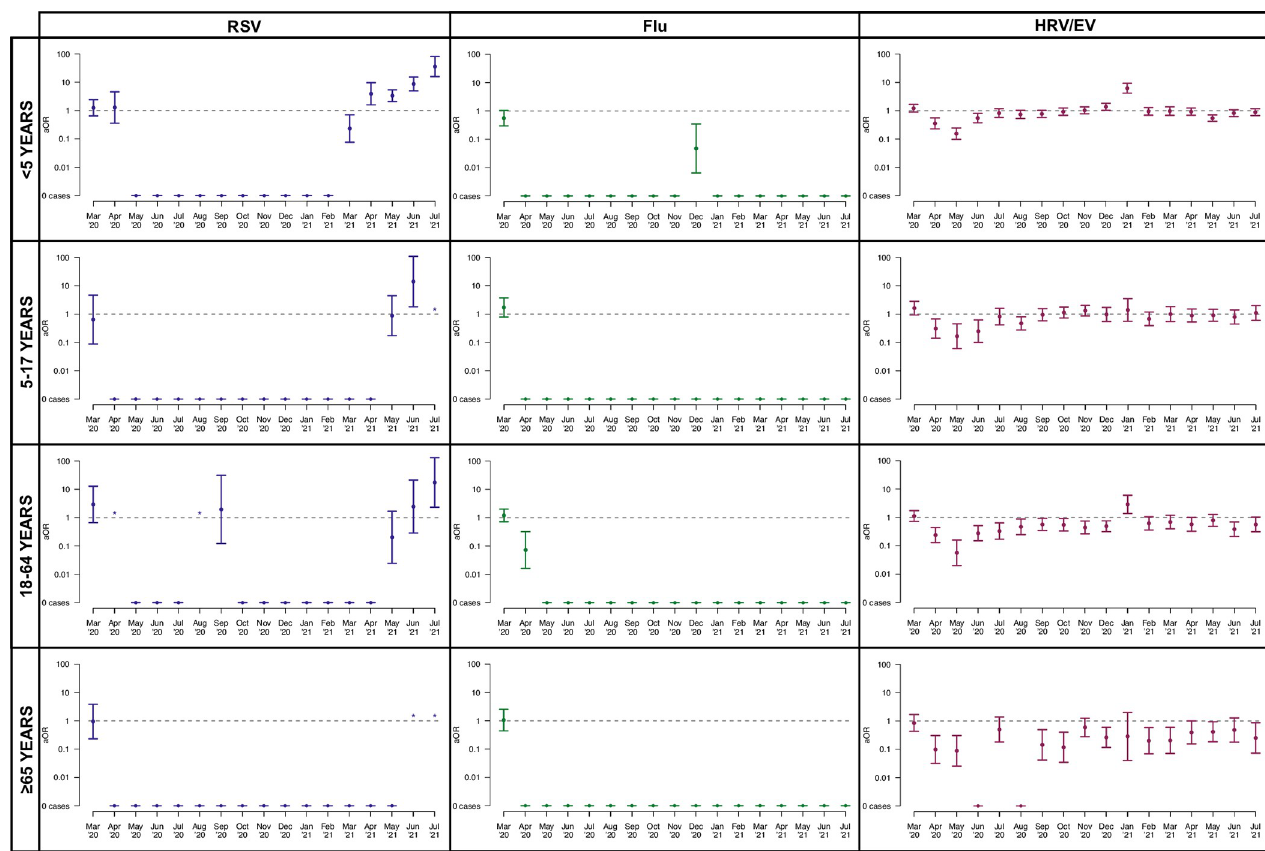
Fig 4. Odds ratios, comparing age group-specific odds of a positive test result for each Flu, RSV, and HRV/EV, for each month over the SARS-CoV-2 pandemic period (March 2020 through July 2021) to the same respective months during prior non-pandemic years. Months in which there were zero cases during the available non-pandemic period are denoted by an